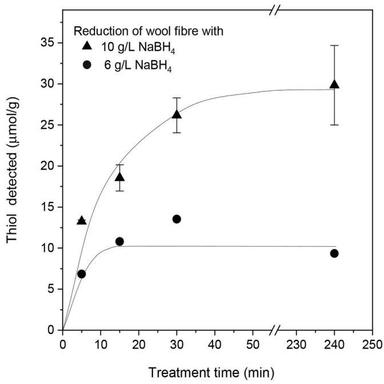
Thiol content of wool fibres as function of treatment time with different NaBH4 concentrations at 25 ◦C.